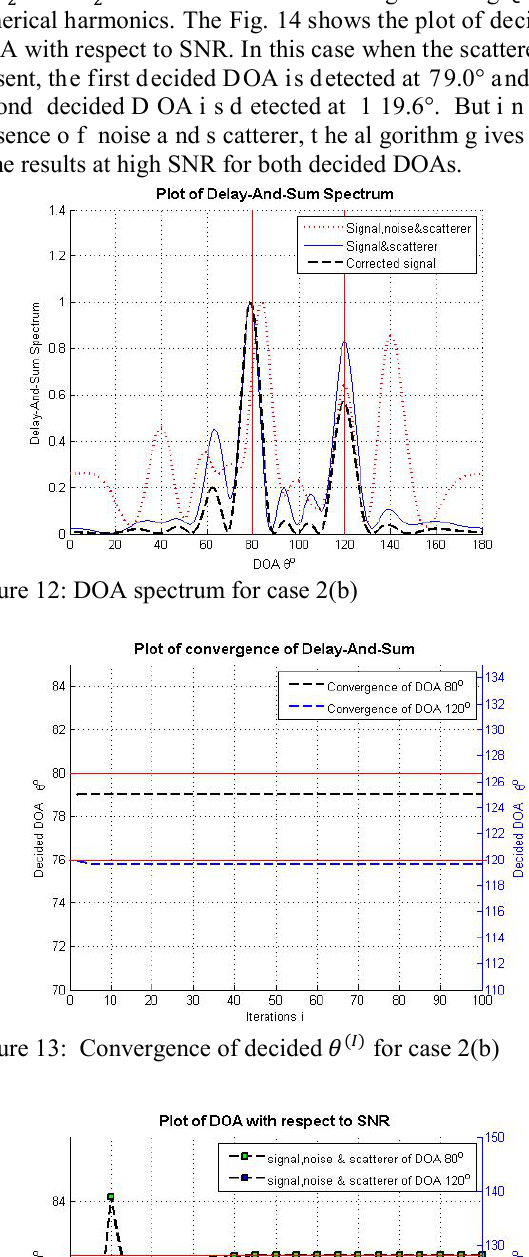
Figure 11: Geometric setup for case 2(b)